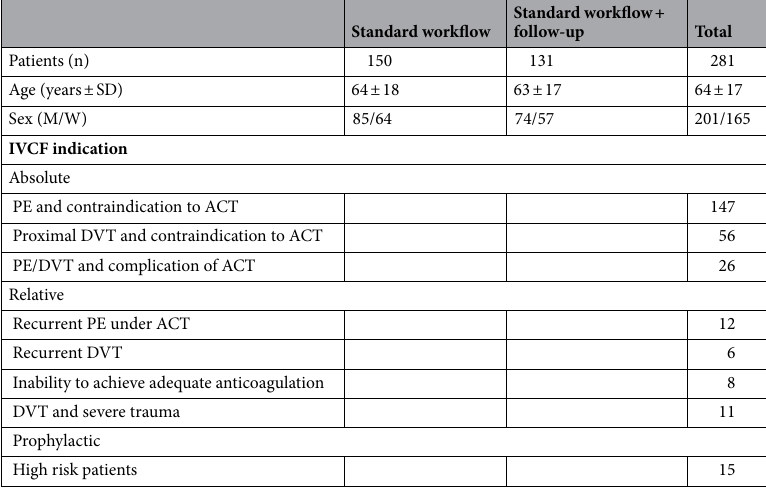
Table 1. Demographic characteristics and indications of filter placement in the study population (survivors with 5 month follow-up). M men, W women, IVCF inferior vena cava filter, ACT anticoagulation therapy, PE pulmonary embolism, DVT deep venous thrombosis.